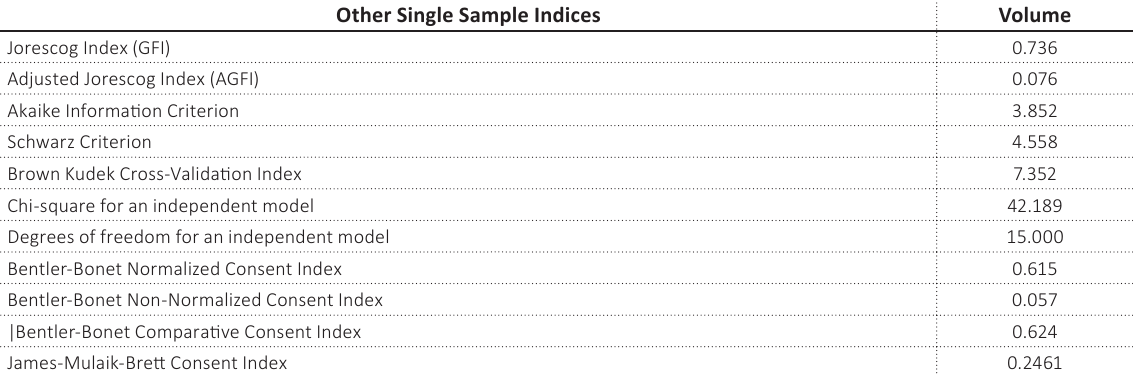
Table 7. Single sample indices of the relationship between the indicators Other Single Sample